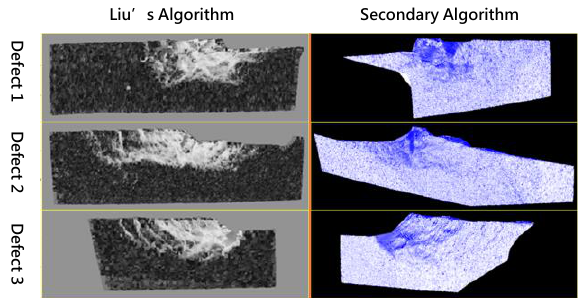
Figure 8. 3D reconstruction of damage detection result in bridge **0147